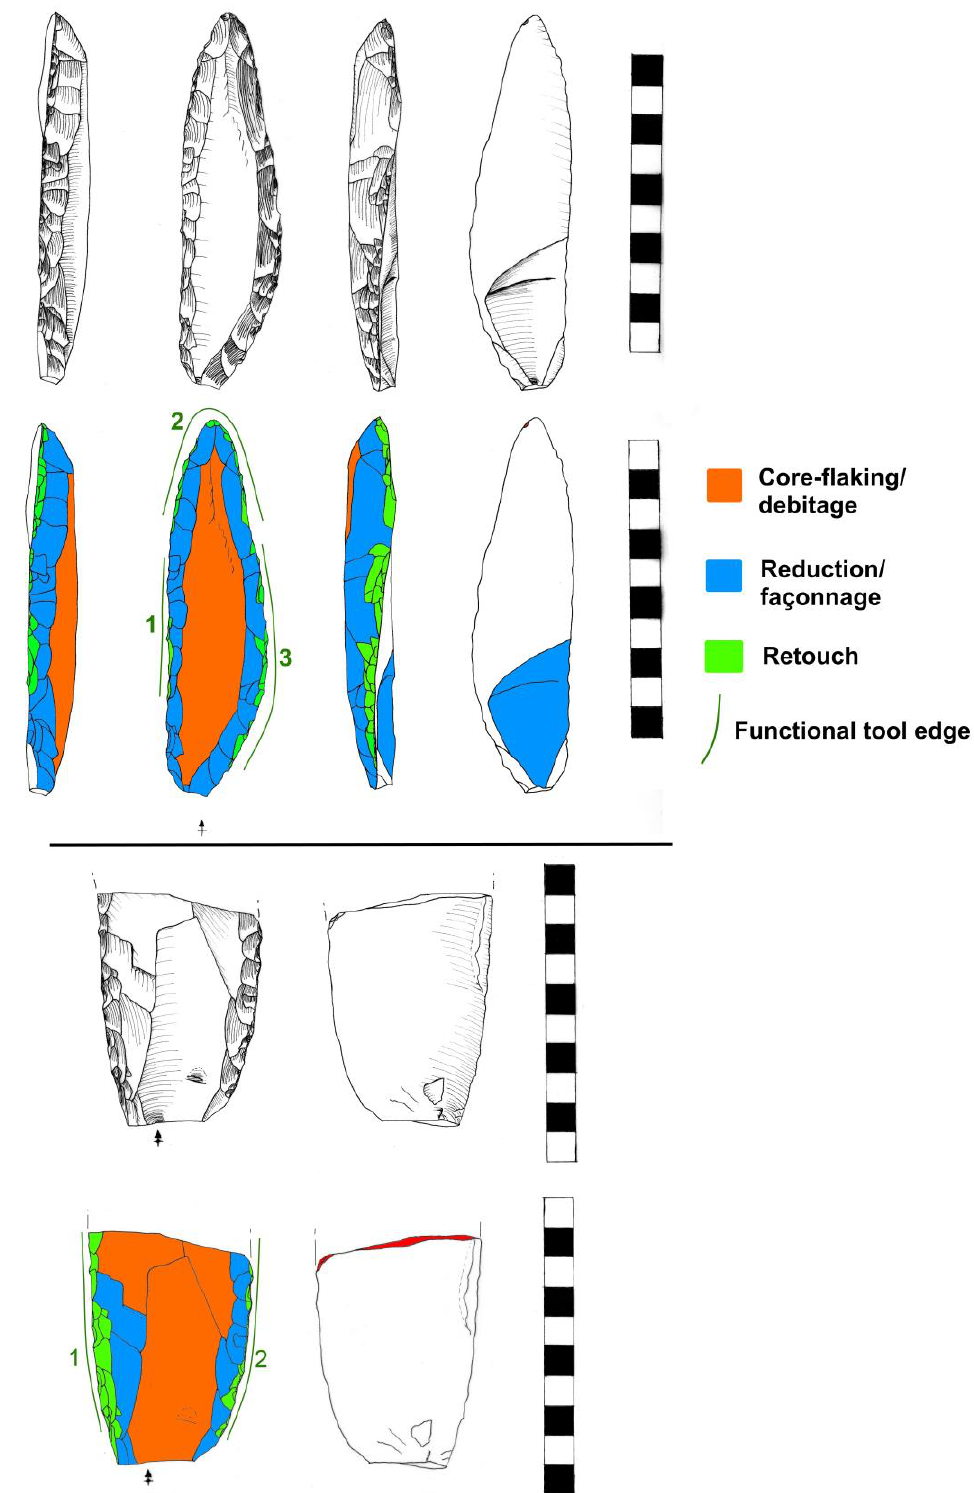
Figure 17. Limaces from Gruta das Araras site. The lower limace is broken at the distal portion. Drawing by the